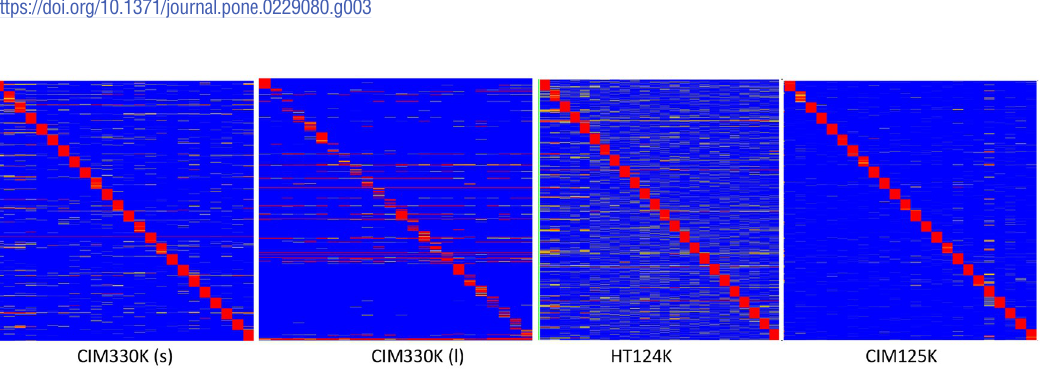
Fig 4. Hierarchical clustering of the top 50 peptides for each of the 24 monocloanls tested. The top 200 peptides for each monoclonal were selected by filtering via pattern-matching to a perfectly discriminatory pattern (i.e. high for each monoclonal, low for the other 23 monoclonals). This filter produced peptides that are unique to each monoclonal, if possible. The values for these 50 � 24 = 1200 peptides is shown for the three microarray libraries. The peptides were clustered using Pearson’s correlation coefficient to group peptides on the Y axis, the X axis lists each monoclonal, and was ordered manually Common reactivity is seen as colored bars off the diagonal